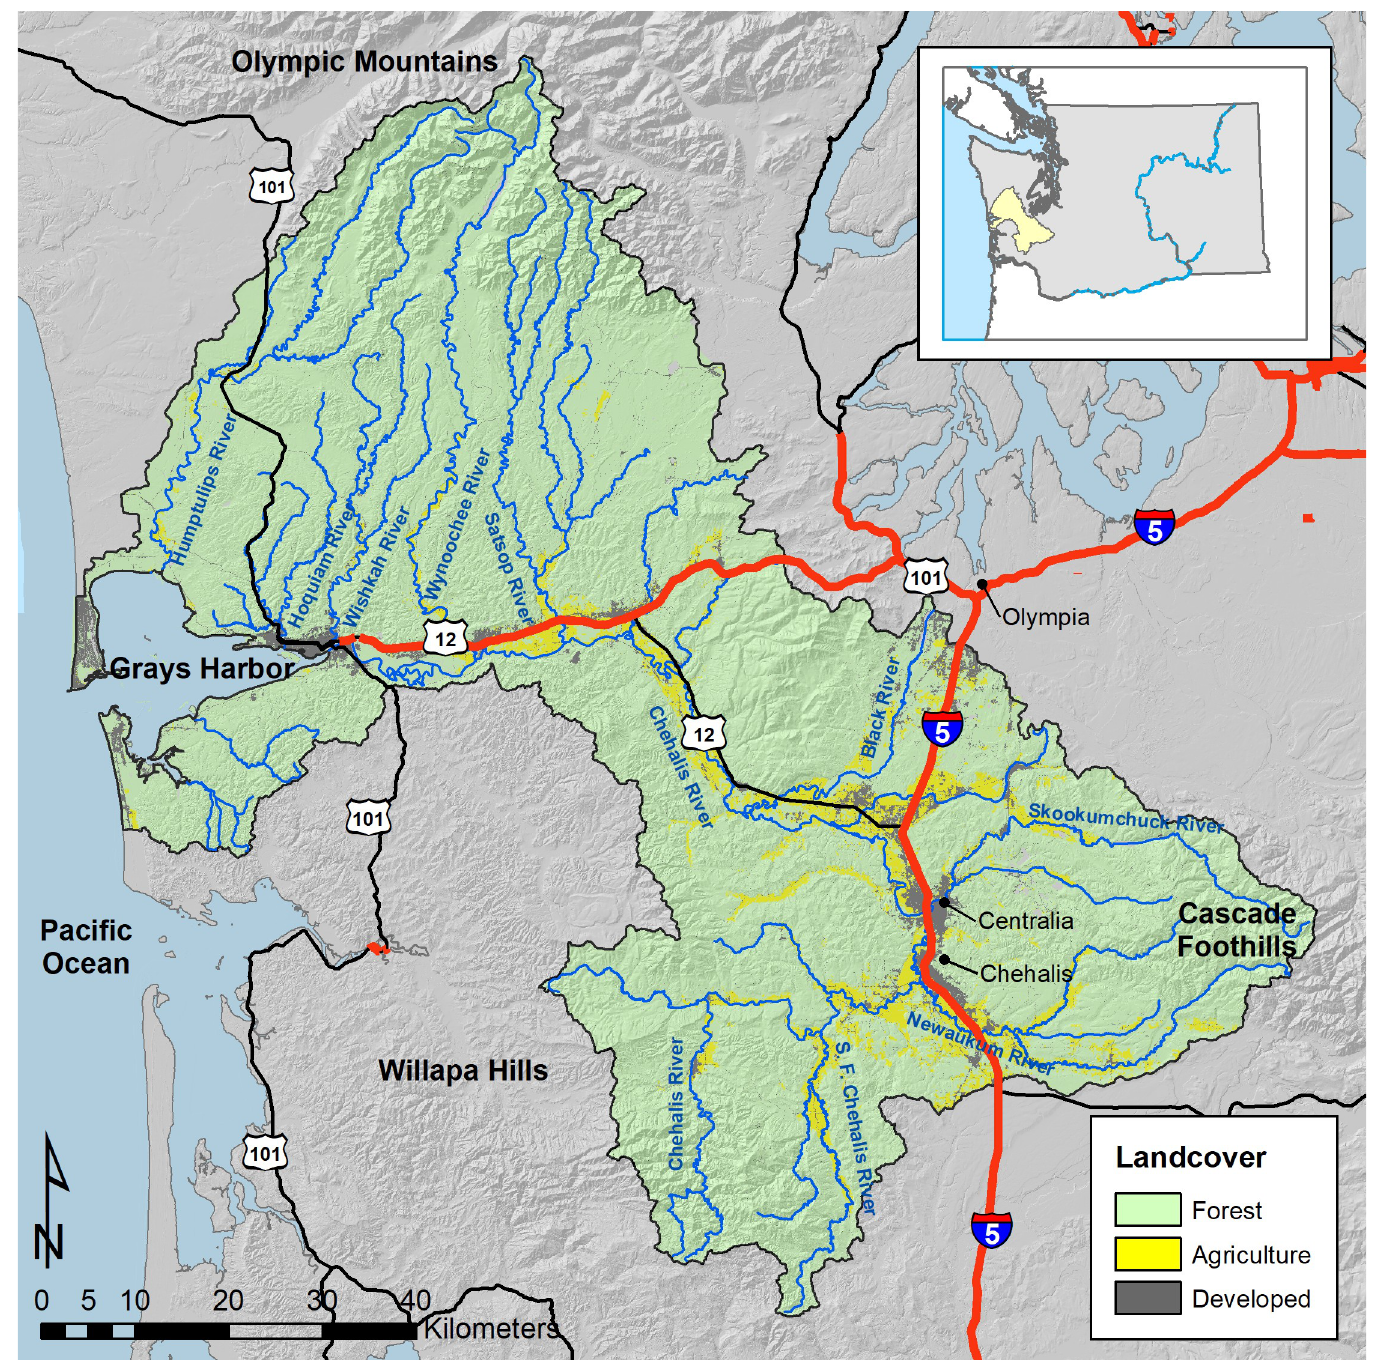
Fig 3. Study area. Map of the Chehalis River basin showing major water bodies, tributaries, cities, towns, highways, and mountain